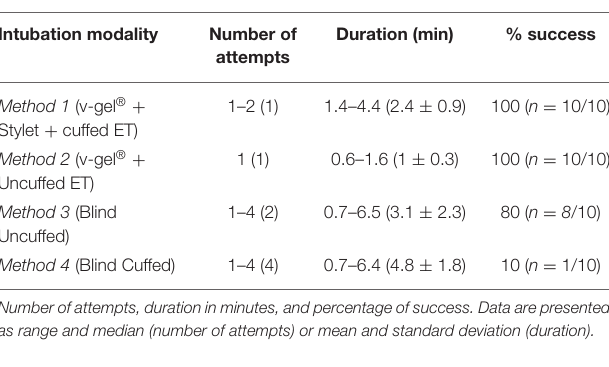
TABLE 1 | Intubation data.